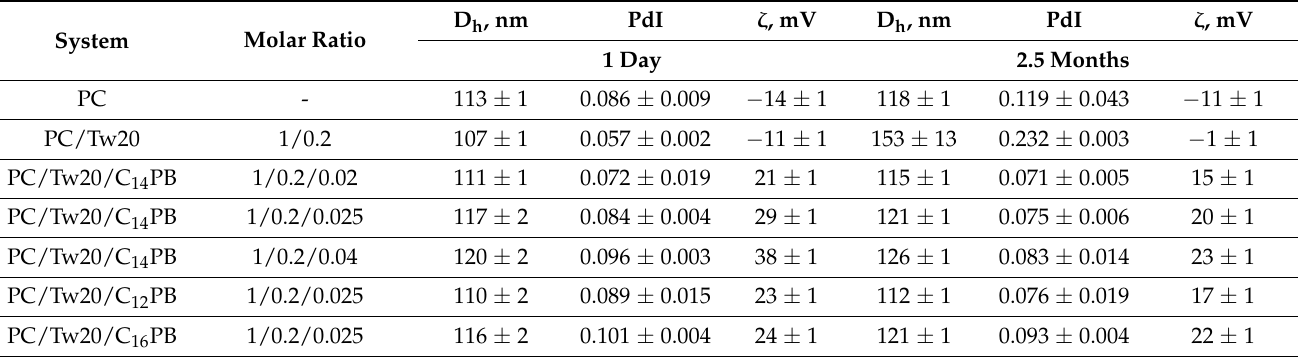
Table 1. Physicochemical properties of transfersomes, modified by C n PB at different molar ratio of components.